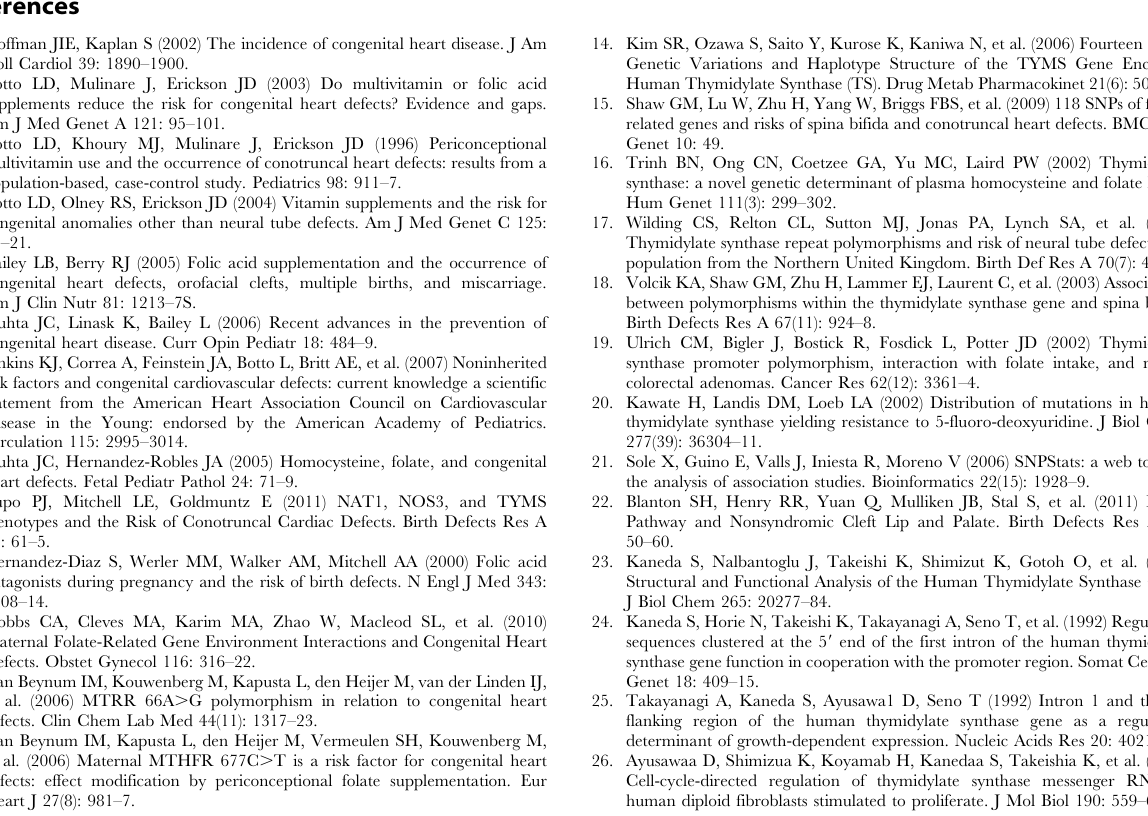
Table S2 The genotype frequency of the 11 identified TYMS polymorphisms in CCSDs patients and controls. (DOC) Table S3 Associations between TYMS polymorphisms and VSD in two independent case-control studies. Table S4 TYMS main haplotype (Frequence . 0.01) anal- ysis of Shanghai group. Table S5 TYMS main haplotype (Frequence . 0.01) anal- ysis of Shandong group. Table S6 High frequency haplotypes (Frequency . 5%) distribution in Shanghai and Shandong